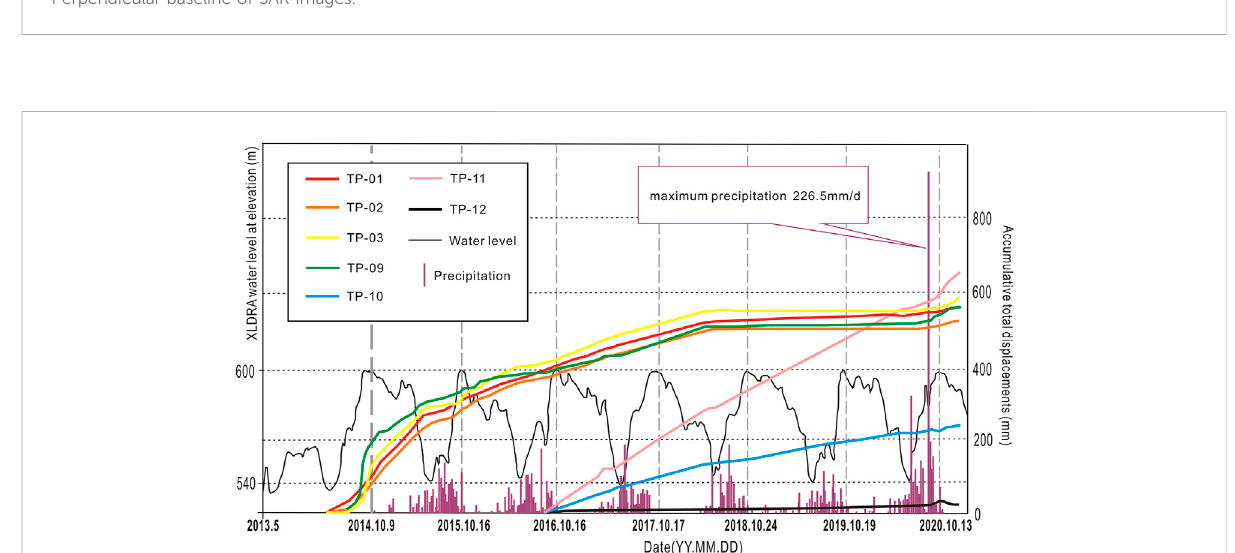
FIGURE 5 Perpendicular baseline of SAR